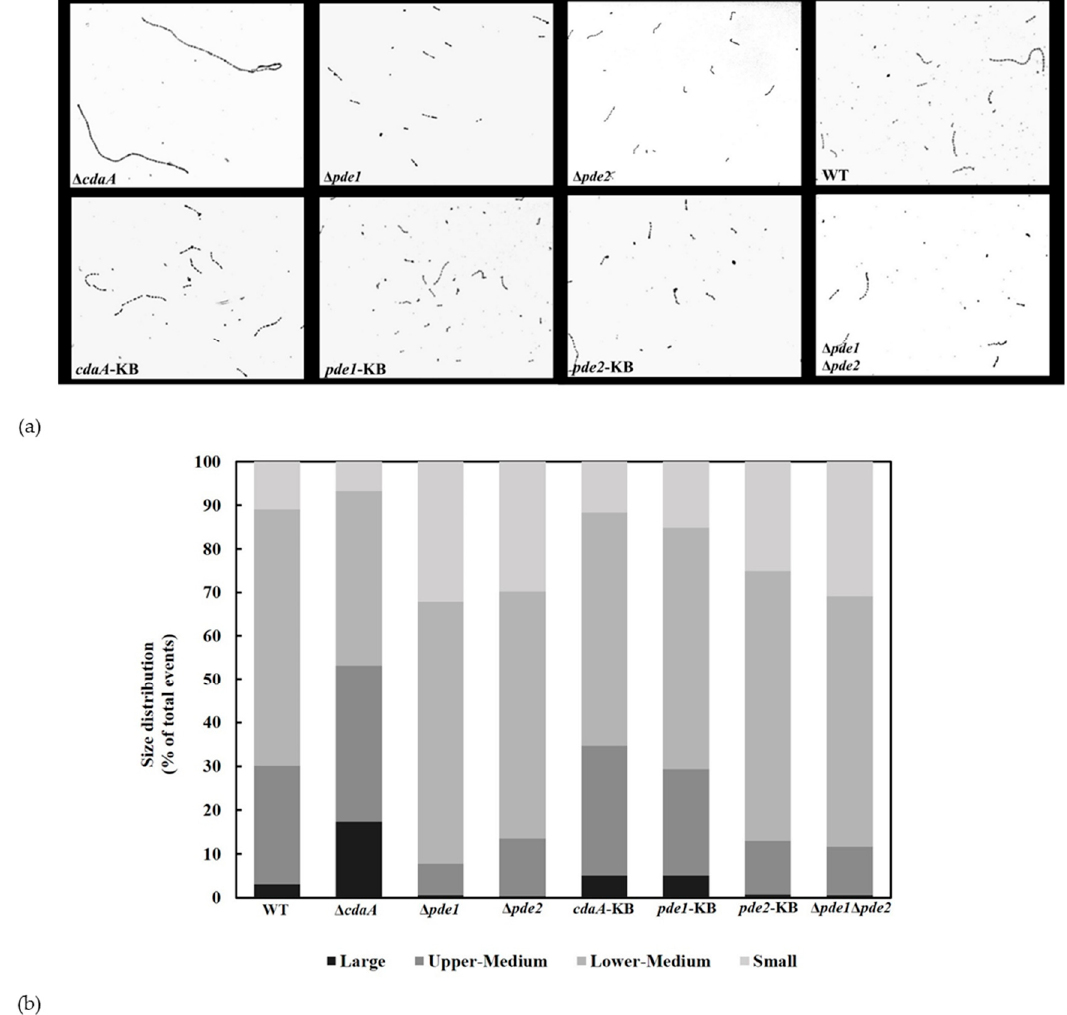
Figure 8. C-di-AMP is involved in regulating chain length. ( a ) Micrographs of safranin-stained cultures grown to OD 600 of 0.5 and photographed with a light microscope (Nikon). ( b ) Flow cytometry was used to sort cells in the culture based on forward scatter and side scatter. Results were gated into four populations, denoted small, lower-medium, upper-medium and large. Results show the average size distribution of the samples in two independent experiments.